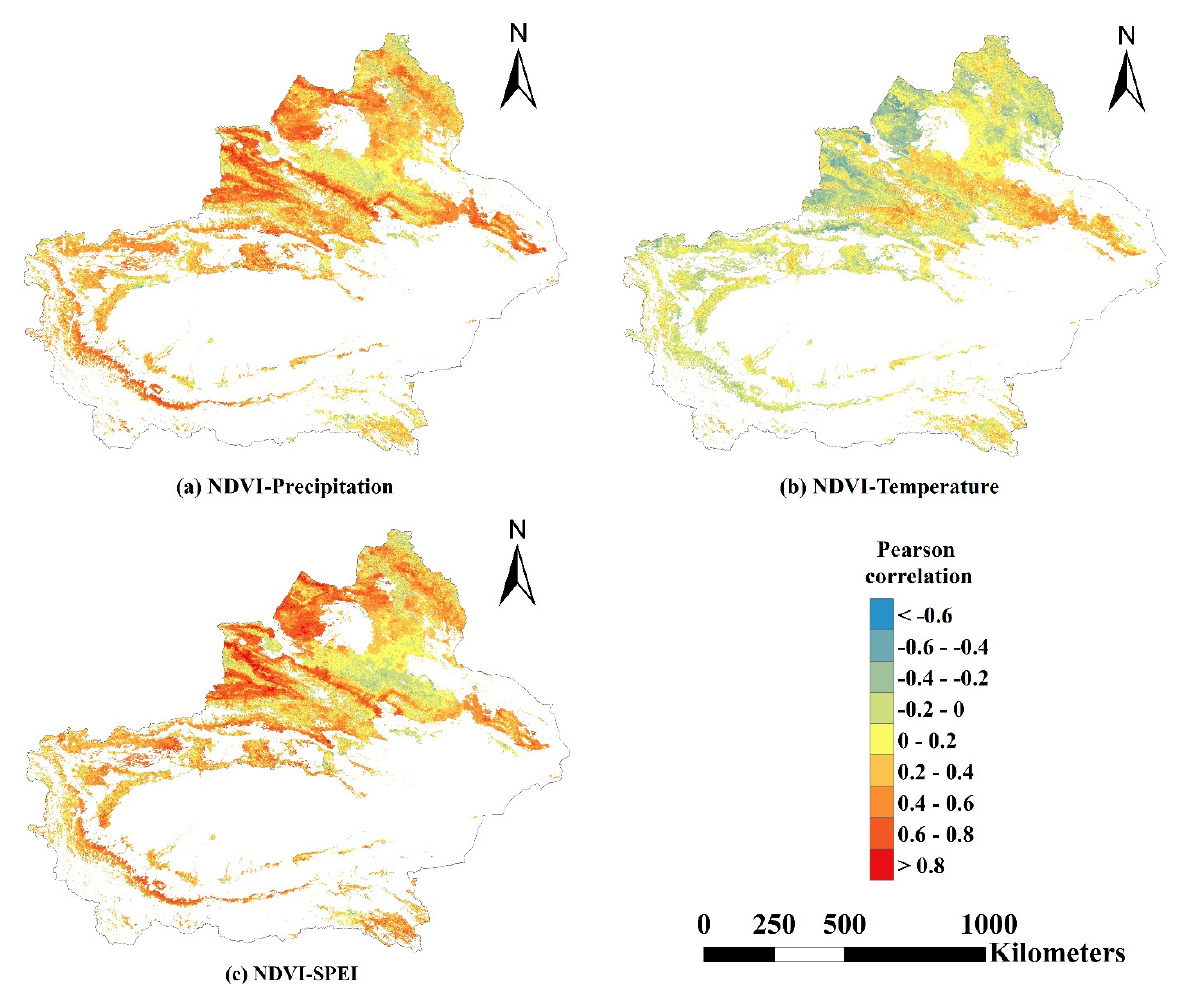
Figure 8. Pearson correlation between the mean value of NDVI during the 2000 − 2019 growing season and ( a ) the average annual total precipitation, ( b ) the average annual mean temperature, and ( c ) the SPEI of TerraClimate dataset.